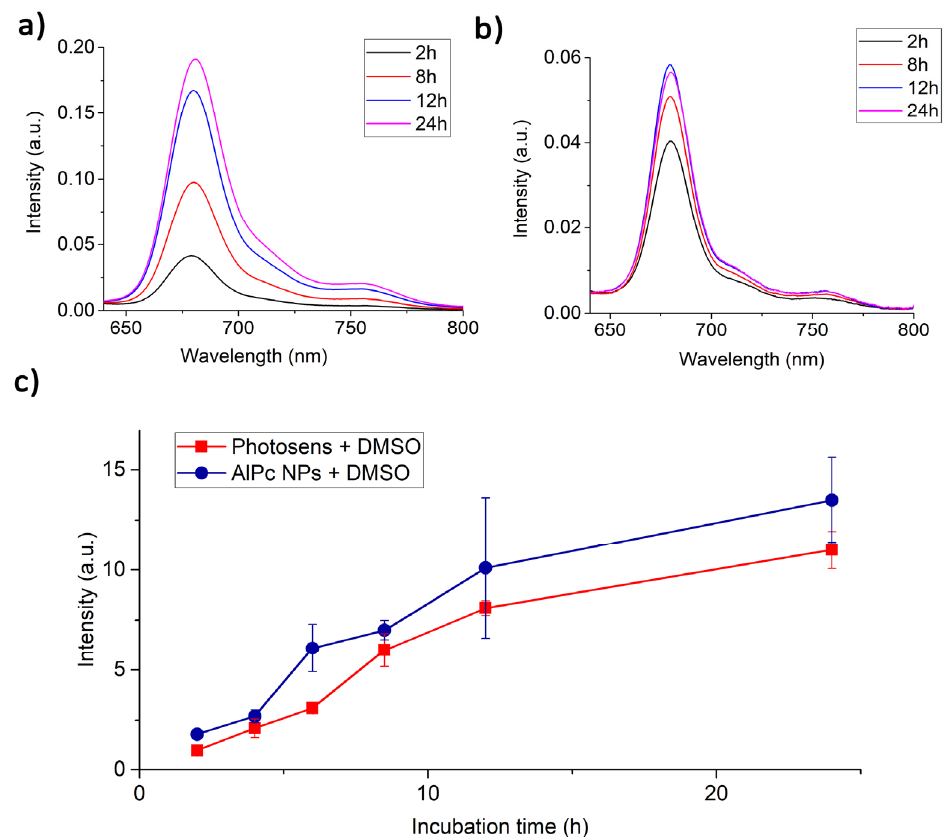
Figure 3. ( a ) Fluorescence spectra of Photosens in HeLa cells depending on the duration of incuba- tion; ( b ) fluorescence spectra of AlPc NPs in HeLa cells depending on the duration of incubation; ( c ) fluorescence intensity of Photosens and AlPc NPs with addition of DMSO in HeLa cells.